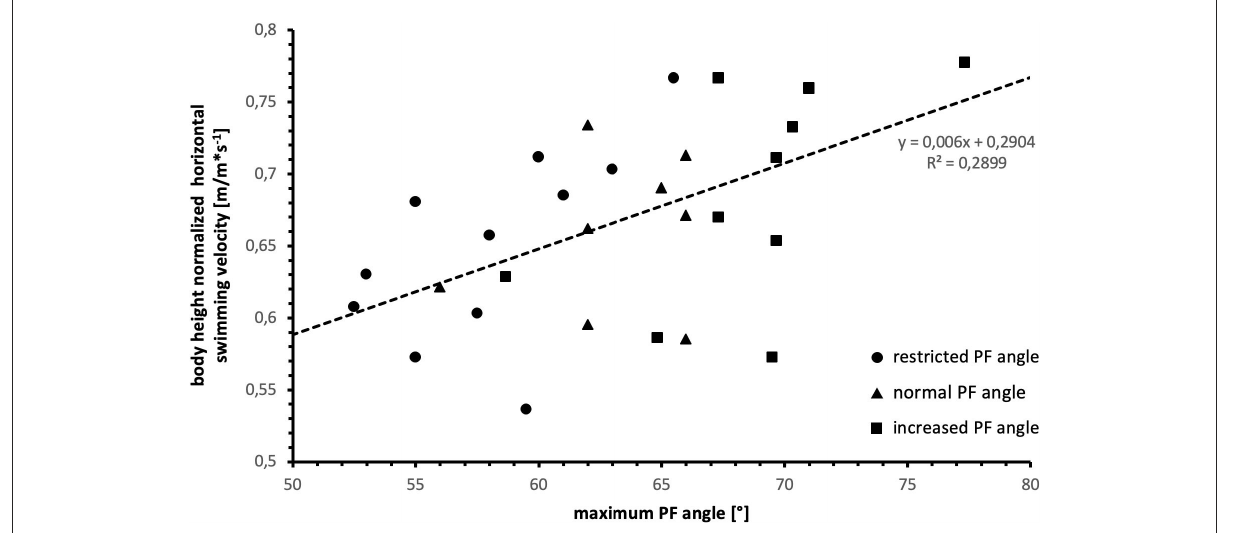
FIGURE3 Relationship between body height normalized swimming velocity and maximum PF angle.